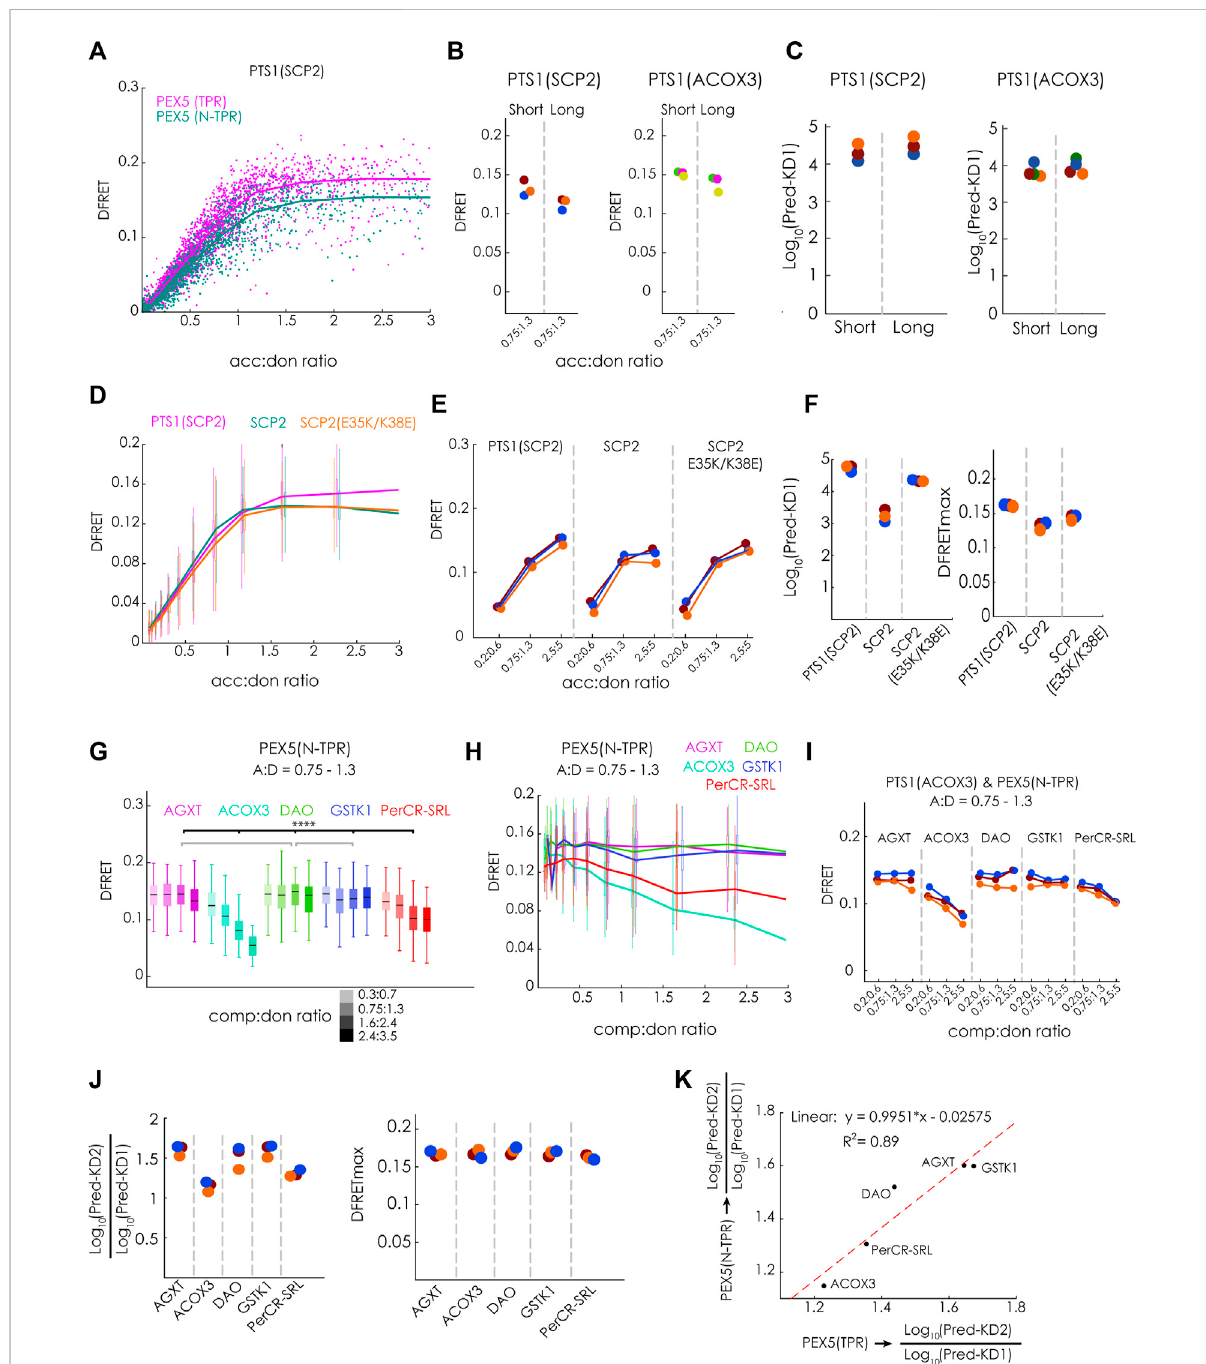
FIGURE 6 N-terminalextensionofthePEX5-TPRdomain(PEX5(N-TPR))hasasimilaraf fi nitytofull-lengthPT1-carryingcargoproteins: (A – F) Bimolecular fl owFRET experiments in pex5 − / − MEF: (A) saturation curves of cells expression EGFP-PTS1(SCP2) as donor and either mCherry-PEX5(TPR) or mCherry-PEX5(N-TPR) as acceptor show different plateau levels; (B) the median DFRET valueof populations sharing an acc:don ratio (0,75 < x < 1,3) ishigherformCherry-PEX5(TPR)thanformCherry-PEX5(N-TPR)whencomparingrepeatedexperimentsandusingeitherEGFP-PTS1(SCP2)or EGFP-PTS1(ACOX3) as binding partners, (C) the results of fi tting these data sets (Pred-KD1 app ) are plotted; (D) saturation curves for mCherry- PEX5(N-TPR)asdonorandeitherEGFP-PTS1(SCP2),EGFP-SCP2orEGFP-SCP2(E35K/K38E); (E) overallpatternofmedianDFRETvaluesfordifferent acc:don subpopulations is consistently observed in three different experiments of the one described in (D) ; (F) the results of the fi tting algorithm (Pred-KD1 app and DFRETmax) are plotted for the interactions in (D) and (E) ; (G – K) fl owFRET competition experiments: pex5 − / − MEF